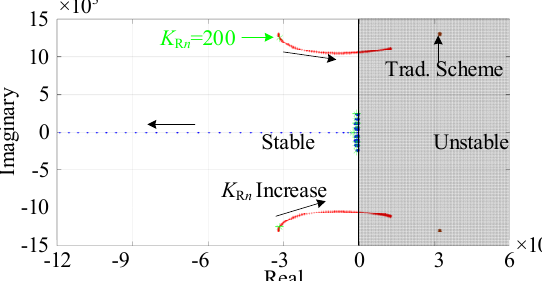
Figure 5. Pole locus of H is ( s ) as a function of K R n , where the proposed modulation scheme and control strategy are applied. The poles with the traditional schemes are also shown for comparison.